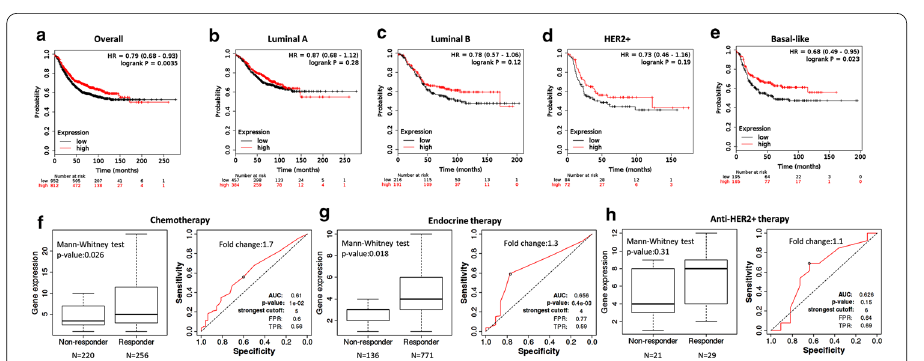
Fig. 7 Prognostic and predictive role of CDKN2B-AS1 gene in breast cancer (BC). a – e Kaplan–Meier plots for BC patients according to their molecular subtypes (Data source: KMplotter). a Overall analysis. b Luminal A. c Luminal B. d HER2 + . e Basal-like BC subtype. f – h Comparison of CDKN2B-AS1 expression level between responder and non-responder and analysis of relapse-free survival at 5 years. (data source: http:// rocpl ot. org) in BC patients receiving different therapeutic modalities. f BC patients receiving chemotherapy. g BC patients receiving endocrine therapy. h BC patients receiving anti-HER2 +